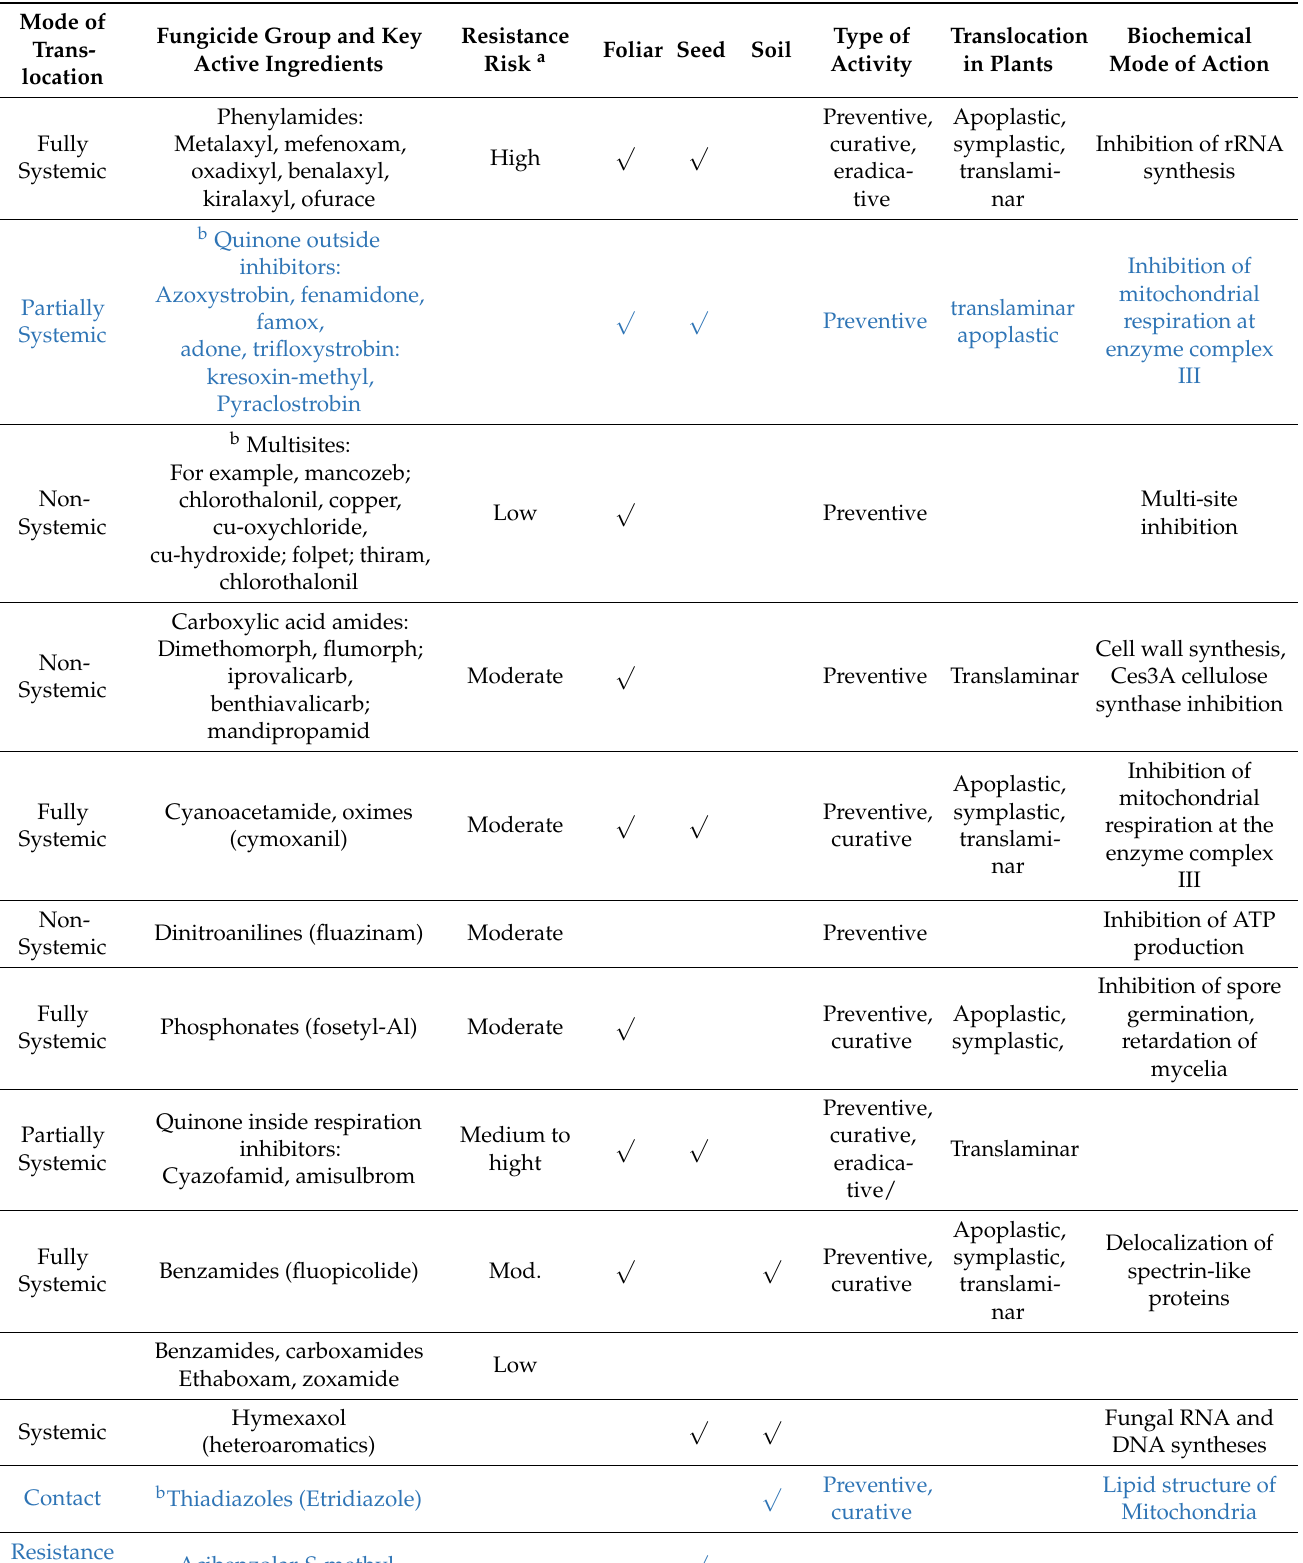
Table 7. Major fungicide groups and key active ingredients, application site, and resistance risk. Adapted from Gisi and Zierotski (2015) [105]; Lebeda and Cohen (2021) [165]; Plimmer, (2003) [166]; and Masielo et al., (2019) [164]. Rows in blue correspond to fungicides that are effective against